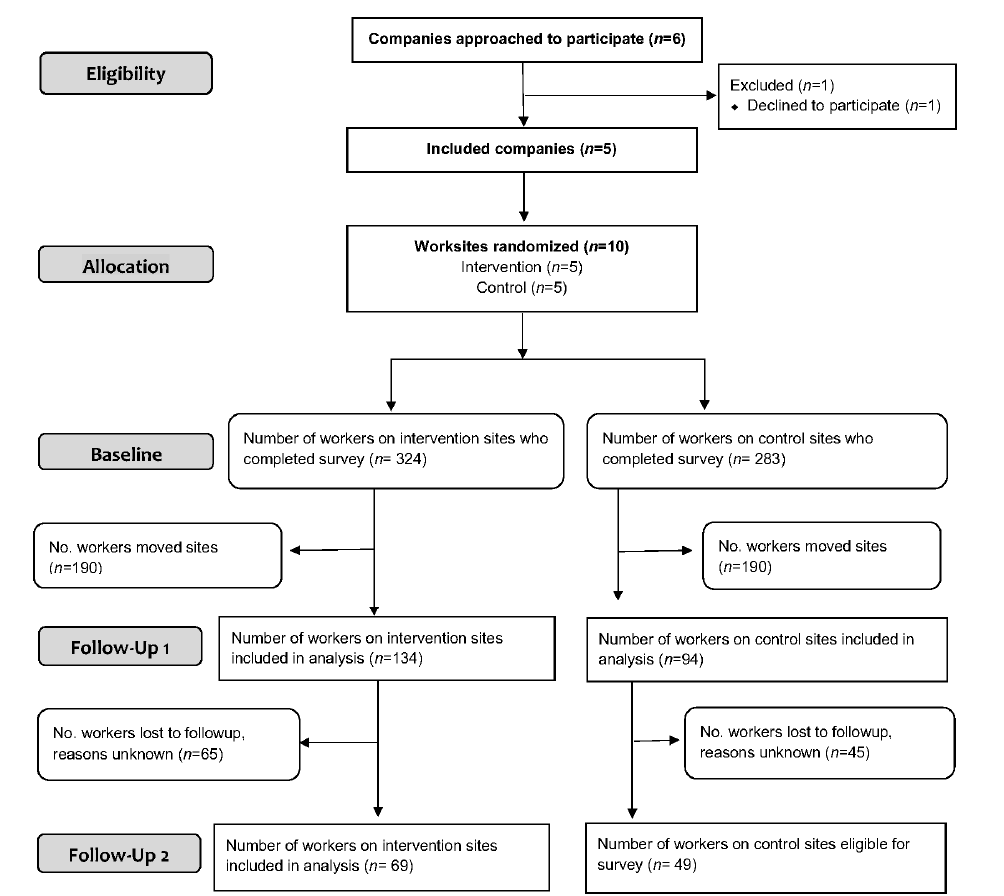
Figure 2. Participant flow through the trial.